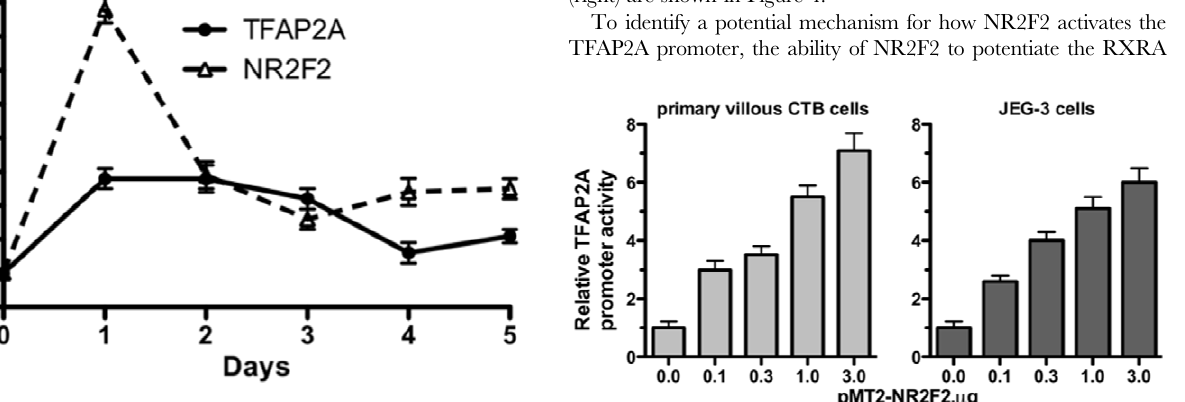
Figure 2. The effect of NR2F2 on TFAP2A promoter activity. Primary villous CTB cells (left) and JEG-3 cells (right) were co-transfected with pGL3 b -TFAP2A-Luc and pMT2-NR2F2 as described in Methods. The amount of luciferase activity in each sample was normalized to the amount of Renilla luciferase activity. Each bar represents the mean of triplicate observations; and the bars enclose 1 SEM. Stimulation of TFAP2 promoter activity by pMT2-NR2F2 was observed in three other experiments using primary CTB cells and JEG-3